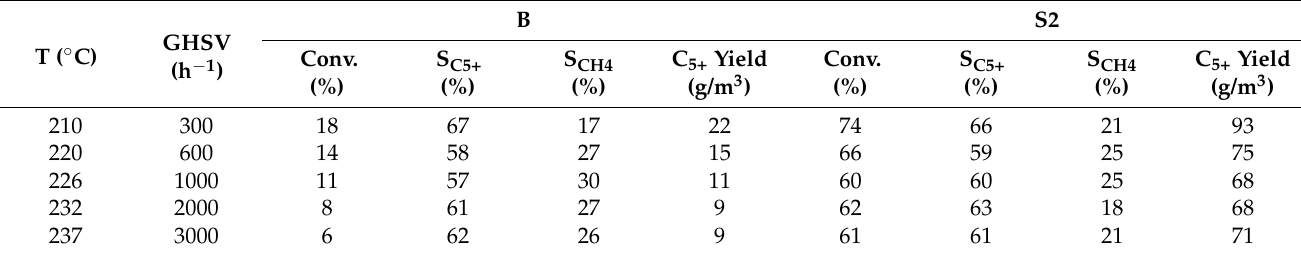
Table 2. FTS catalytic properties * obtained during testing of catalysts S2 and B (P = 2 MPa).